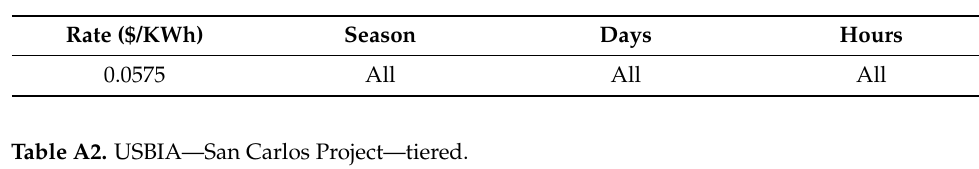
Figure A1. Rate A (Salt River Project E-65) time-of-use. Table A1. Ocotillo Water Conservation District—flat.